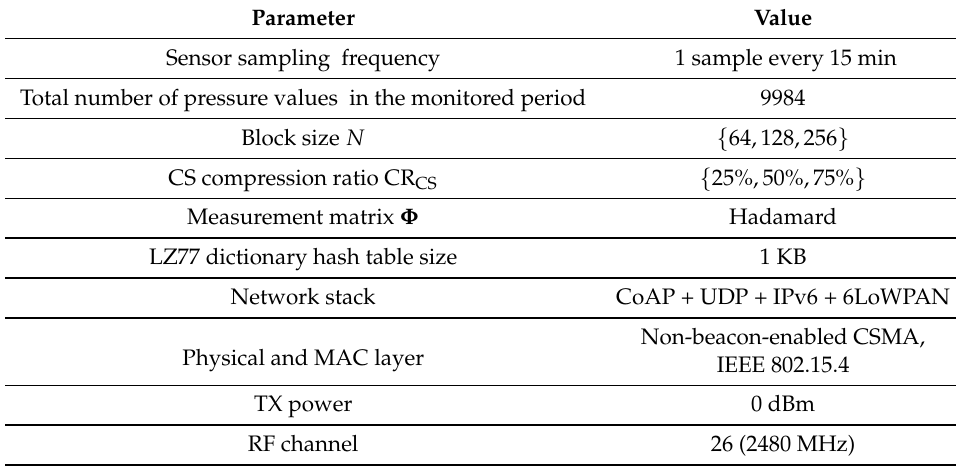
Table 2. Experimental setup